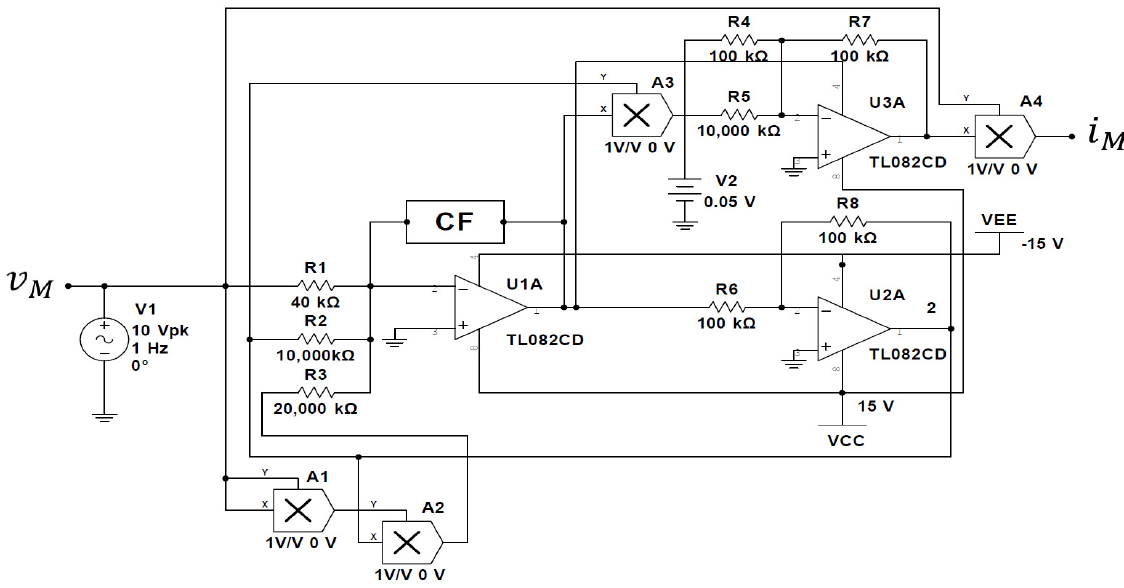
Figure 4. The realized circuit of the fractional-order memristor that is described by Equation (11).